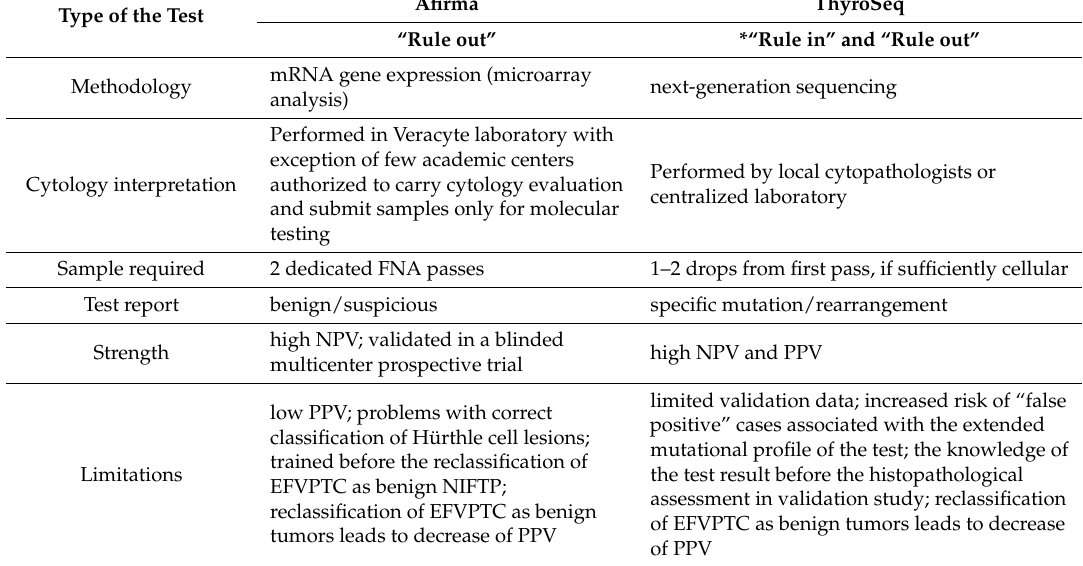
Table 1. Comparison of two commercially available molecular tests for indeterminate thyroid fine-needle aspiration